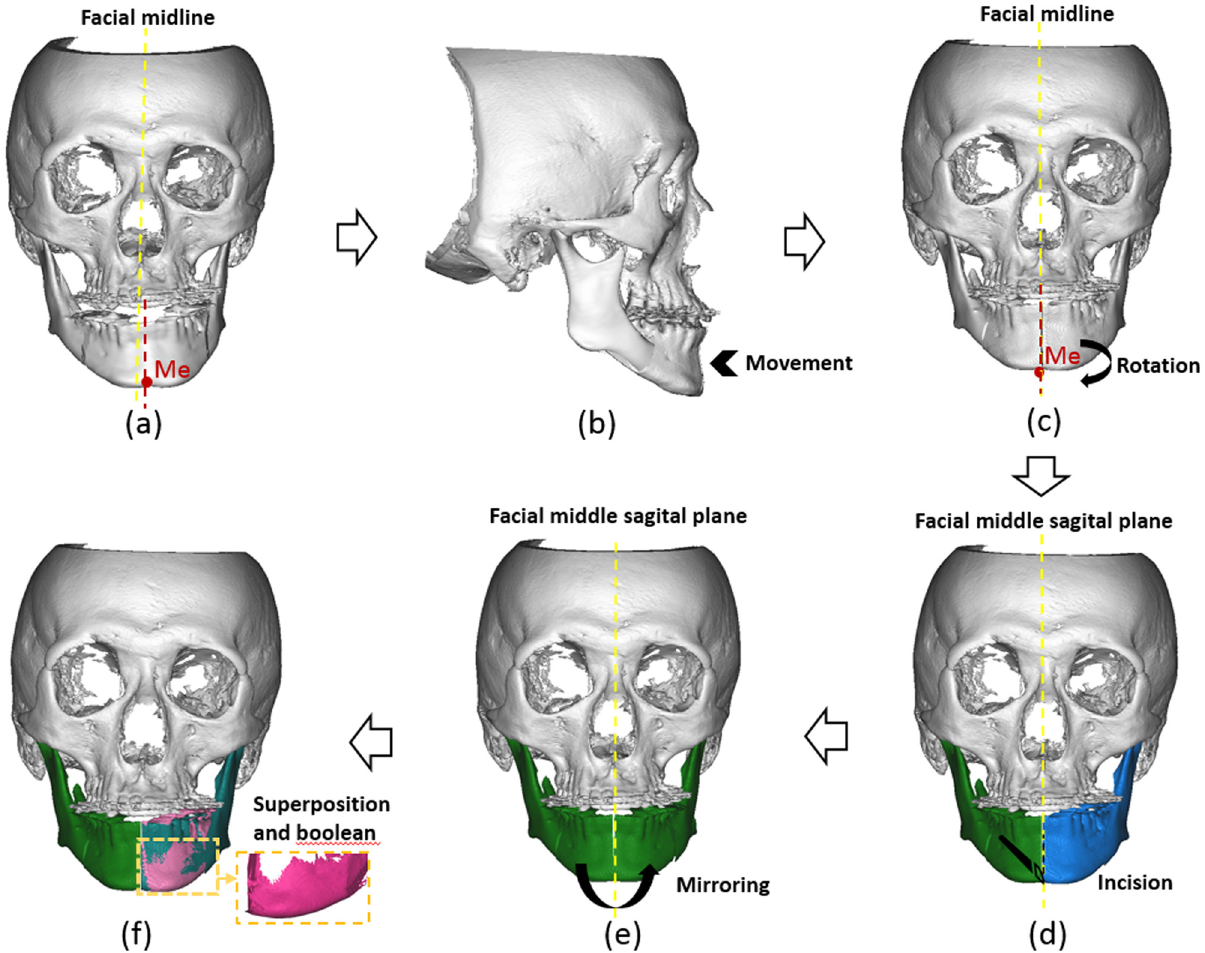
Fig 1. Procedure for measurement of the mandibular residual asymmetry: (a) Incision design and measurement before surgery; (b) Mandible segment backwards to normal maxillo-mandibular relationship; (c) Me point — facial midline alignment by mandibular de-rotation; (d) Segmentation along the facial middle sagittal plane, green color represents the elongation hemi-mandible; blue color represents the normal hemi-mandible; (e) Mirroring of elongation hemi-mandible along facial middle sagittal plane; (f) Superimposition and boolean operation of mirrored elongation hemi-mandible and normal side, pink color in the box represents the residual asymmetry between the two sides of the mandible.